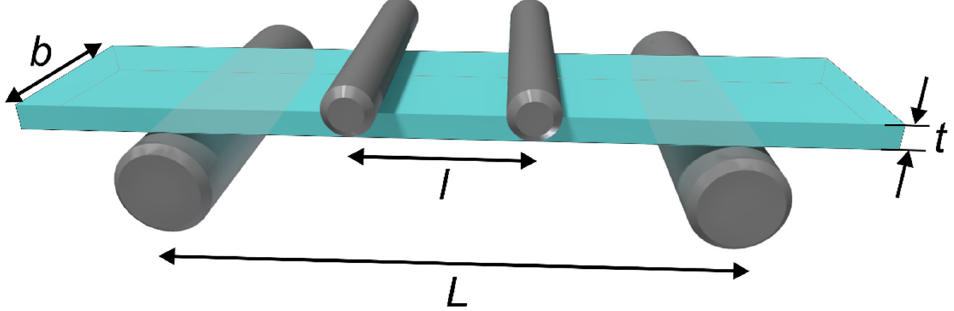
Figure 3 . The four-point bending test setup. Figure 3. The four-point bending test